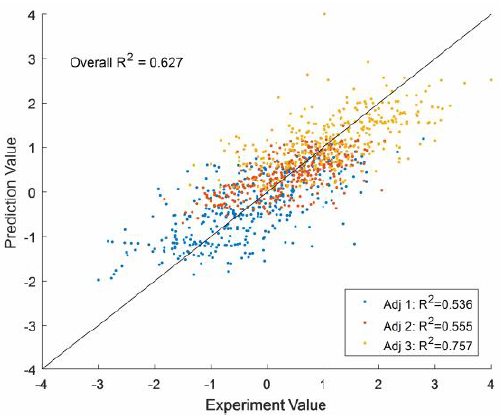
Figure 3. The 10 × 10 ANN structure training result for three adjective pairs.